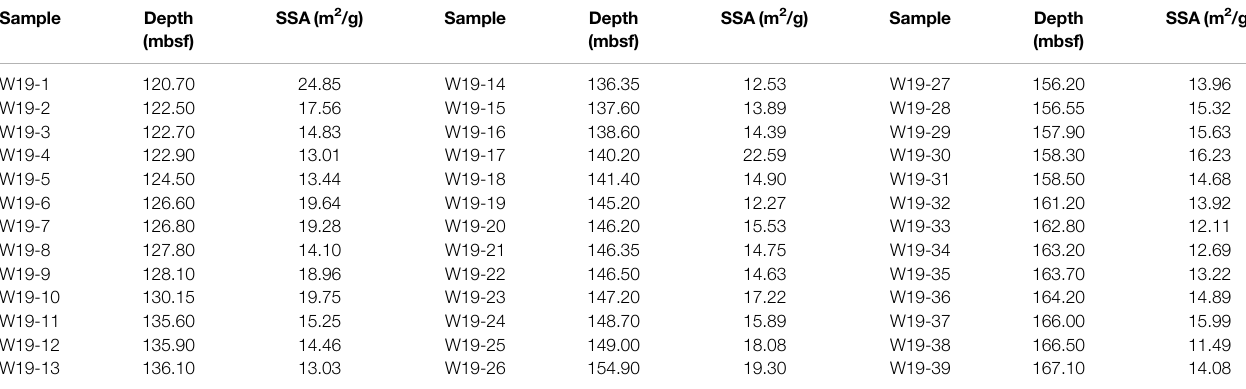
TABLE 2 | The result of Speci fi c surface area. Sample